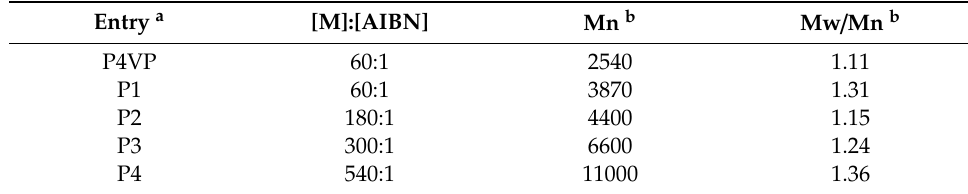
Table 1. Structural parameters of the P4VPx-co-PDMAEMA polymer.